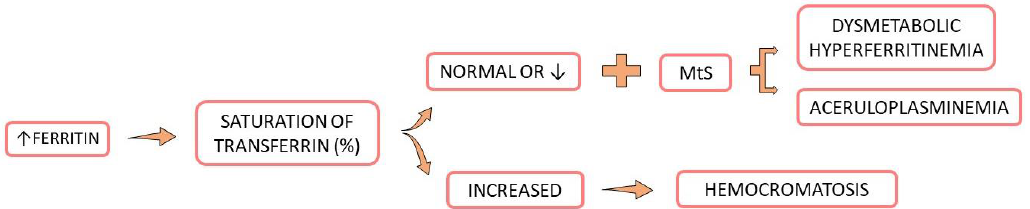
Figure 3. Consequences of hyperferritinemia. Hyperferritinemia and normal or reduced saturation of transferrin and metabolic syndrome risk factors result in dysmetabolic hyperferritinemia. If the saturation of transferrin is elevated, the condition is probably hemochromatosis. MtS: metabolic syndrome, ↓ : decrease.